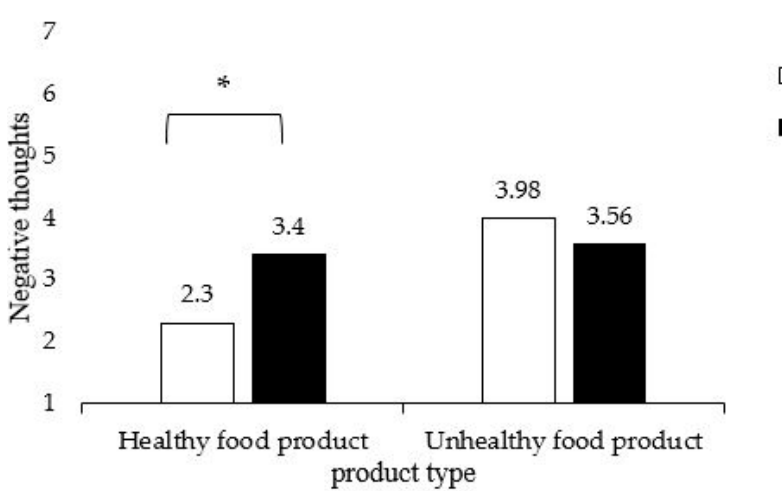
Figure 1. Results of Study 1. The interaction of ad type and product type on negative thoughts. Note: * significant at p <